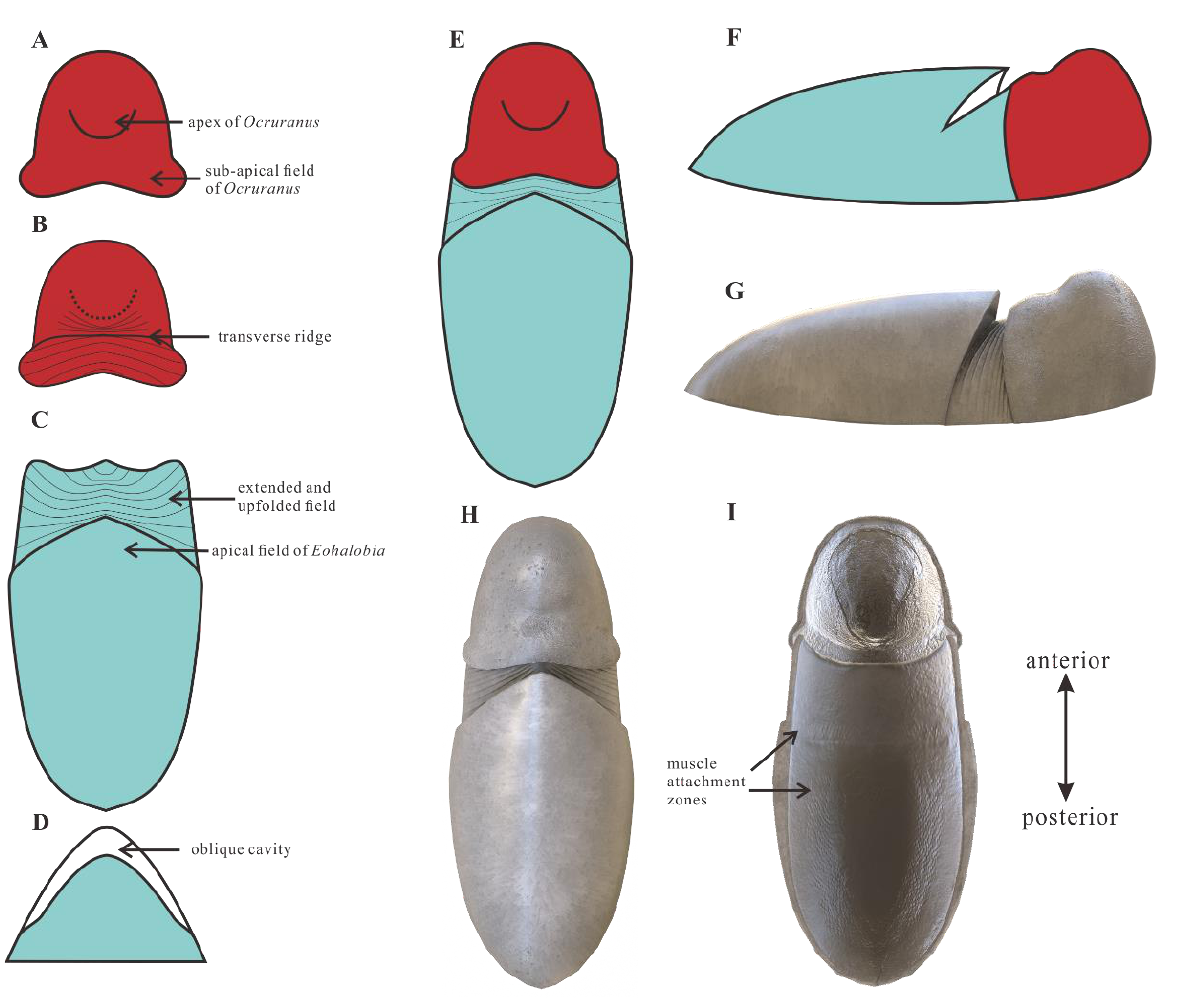
Figure 7. Two and three-dimensional reconstructions of Ocruranus – Eohalobia group. ( A ) Exterior view of Ocruranus sclerite, showing the apex and sub-field of Ocruranus sclerite. ( B ) Interior view of Ocruranus sclerite, showing the transverse ridge. ( C ) Dorsal view of Eohalobia sclerite, showing apical field, extended and upfolded field (weakly mineralized structure) of Eohalobia sclerite. ( D ) Proximal view of Eohalobia sclerite, showing the oblique cavity of Eohalobia sclerite. ( E ) Dorsal view of the complete profile of Ocruranus – Eohalobia group. ( F ) The lateral view of the complete profile of Ocruranus – Eohalobia group. ( G – I ) Lateral, dorsal, and ventral view of three-dimensional Ocruranus – Eohalobia group, respectively, ( I ) showing the distributions of muscle attachment zones.